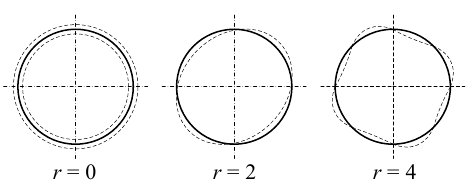
Figure 1. Deformation shapes of the stator.